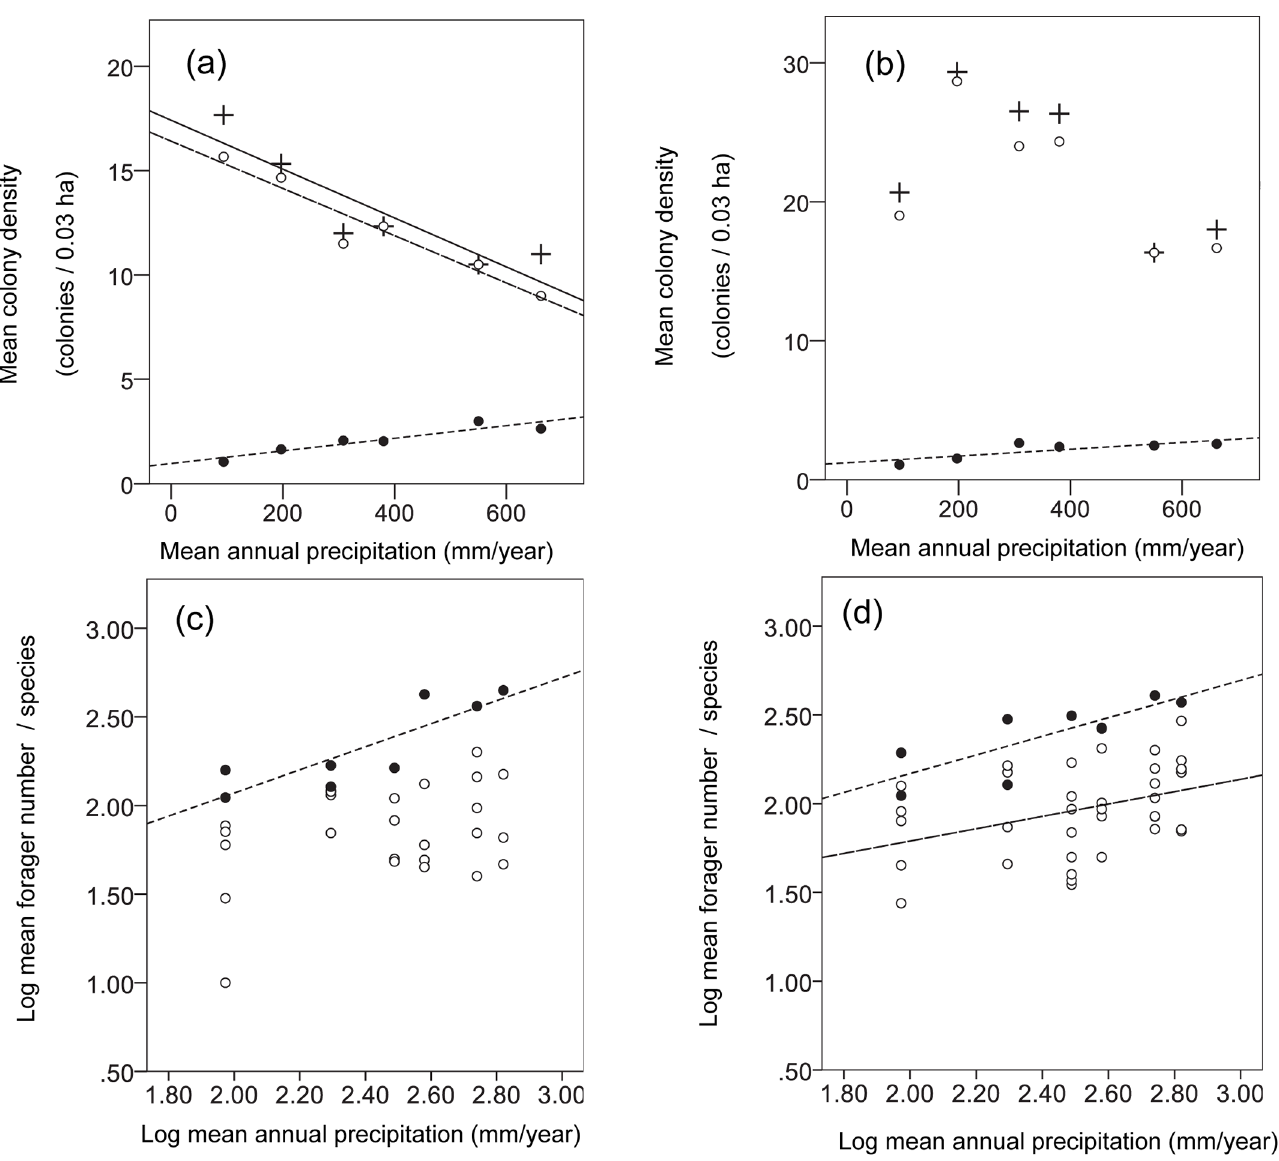
Fig 1. Relationships between colony density or forager number per species and mean annual precipitation in 2007 (a,c) and 2008 (b,d) of the generalist species (open circles, dashed line) or both functional groups when monitored together (plus sign, solid line) in the 20 × 15 m plots. The same relationships were also obtained for the specialized seed eaters (filled circles, dotted line) in the 100 × 100 m plots in 2008 (b,d) and 2009 (a,c) and standardized according to the 20 × 15 m